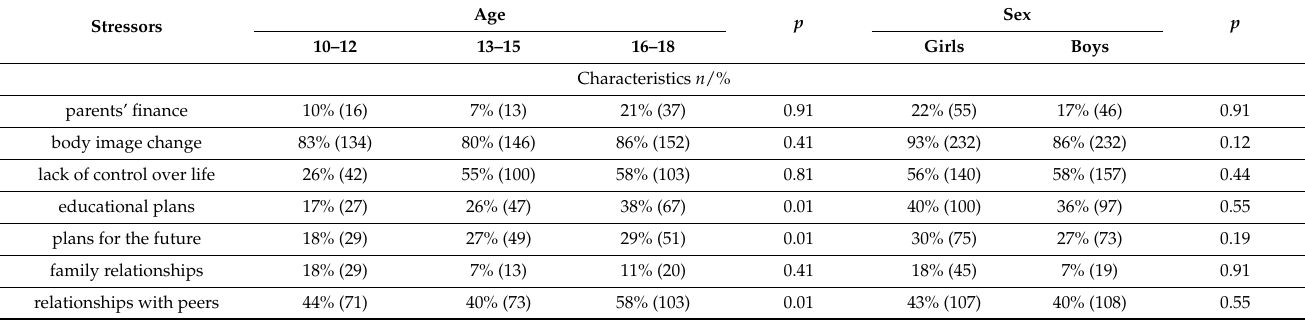
Table 5. Stressors among the respondents.